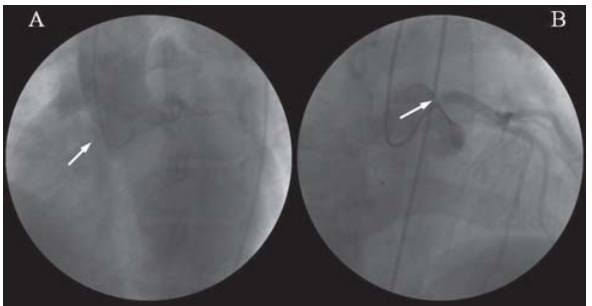
Fig. 1 - Angiografia coronária e aortografia. Angiografia mostrando oclusão completa do óstio da artéria coronária direita (A) e lesão ostial no tronco da artéria coronária esquerda (B)